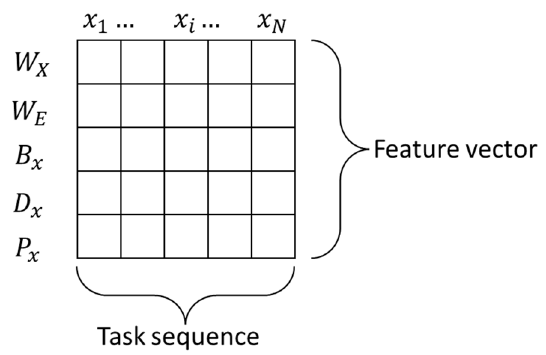
Figure 5. Input matrix.